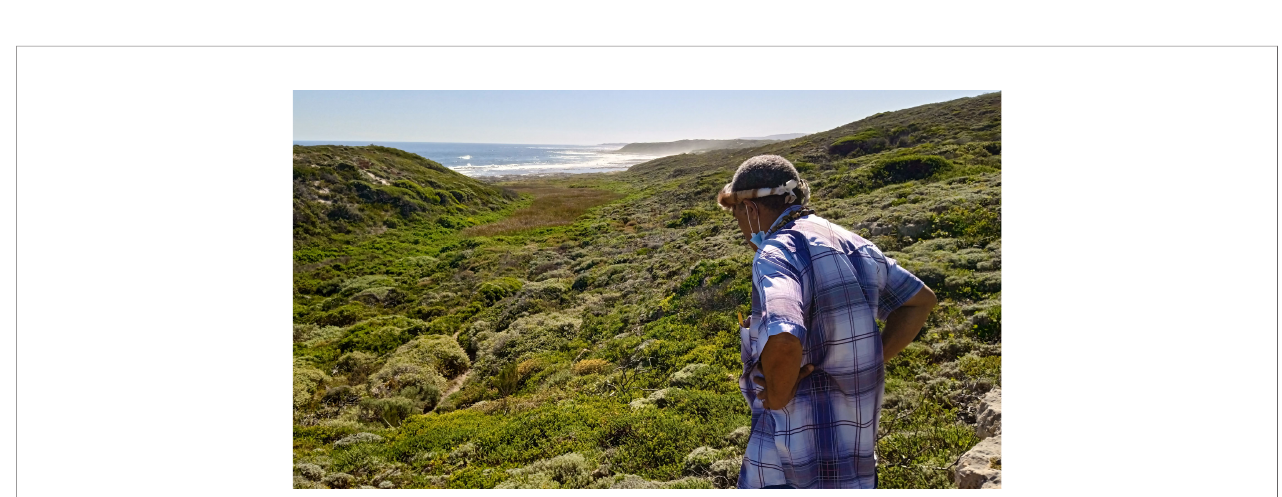
FIGURE 3 | Picture of Paramount Chief Human of the Kei Korana tribe in the Eastern Cape, looking out over what used to be areas where the Indigenous Khoi and San people lived.